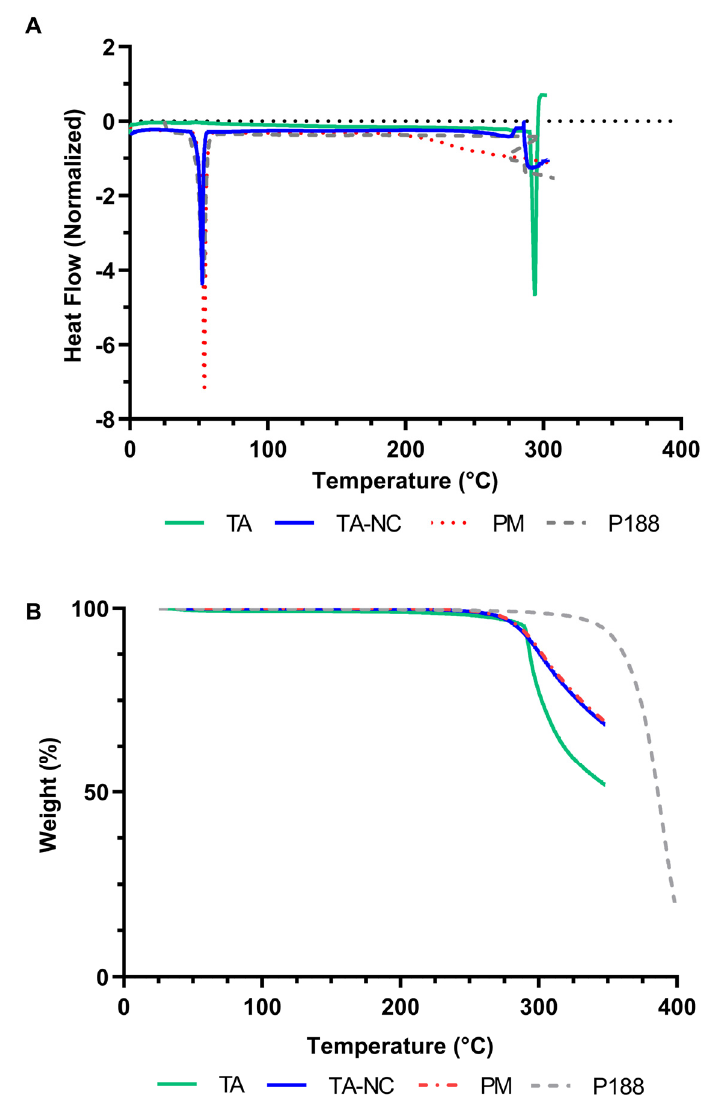
Figure 6. ( A ) Differential scanning calorimetry (DSC) of mTA, P188, PM and TA-NC. ( B ) Thermo- gravimetric analyses (TGA) of mTA, P188, PM and TA-NC.